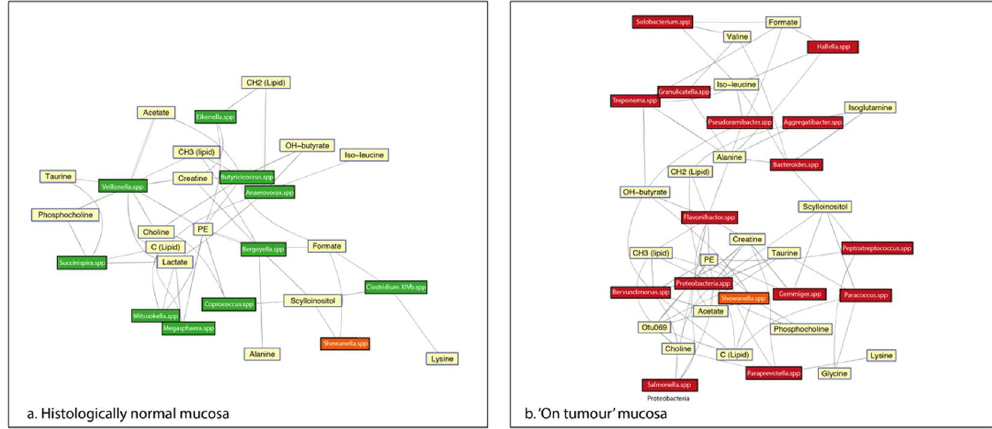
Figure 5. Metabolic network map of mucosal metabolites statistically over and under-represented in colon cancer and normal associated mucosa (NAM) as detected by 1 H NMR-MAS regressed against the 16s rDNA OTU data. The spp. in green are microbiota over-represented in the NAM and those in red are over-represented in cancer. Shewanella spp. was the only bacteria class represented in both